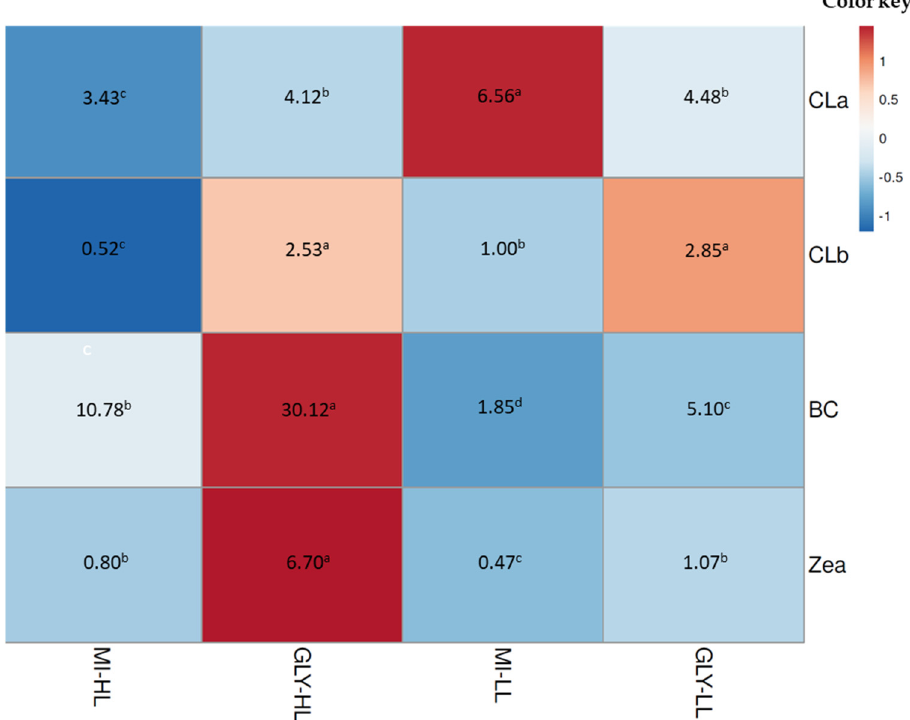
Figure 4. Heat map colors correspond to lower (blue) and higher (red) abundance for the main pigments of D. salina cultured under mixotrophic conditions. The real concentrations of pigments (pg cell -1 ) are in the heat map figure. MI-HL and Gly-HL correspond to the inorganic medium and glycerol exposed to 300 μ mol photons m -2 s -1 , respectively. MI-LL and Gly-LL correspond to the inorganic medium and glycerol exposed to 50 μ mol photons m -2 s -1 , respectively. Pigments (CLa: chlorophyll a , CLb: chlorophyll b, BC: β -carotene, Zea: zeaxanthin) were separated and identified by HPLC. Different letters in the same row are significantly different between pigment content for each treatment.